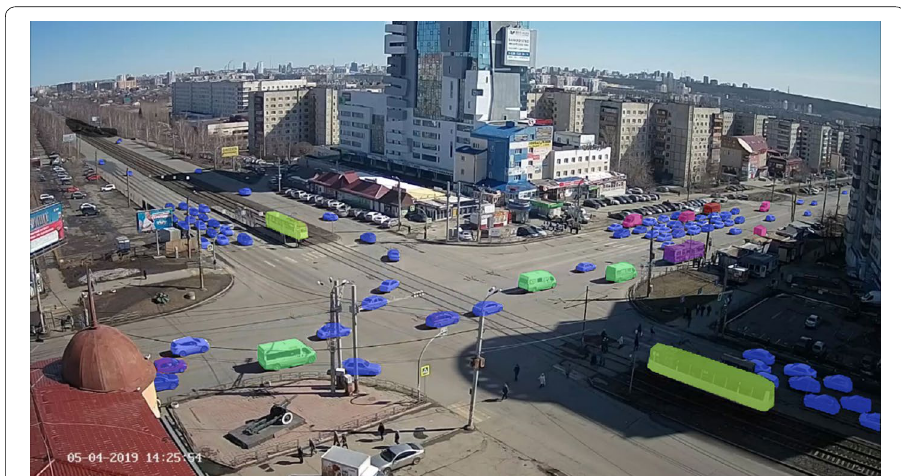
Fig. 1 Example of an image from our dataset. Blue, yellow, green, red, violet, pink and black polygons stands for the “car”, “tram”, “van”, “bus”, “trolleybus”, “truck” and “unlabeled” objects respectively